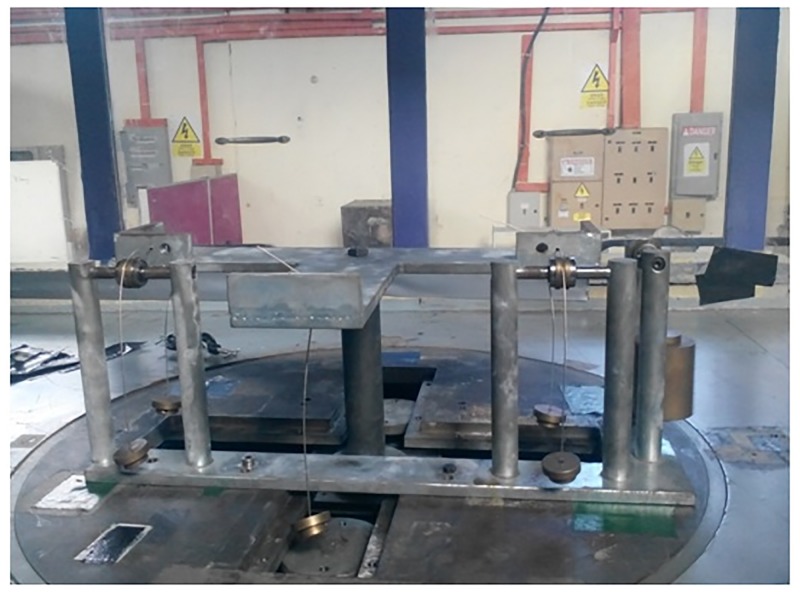
Calibration rig.